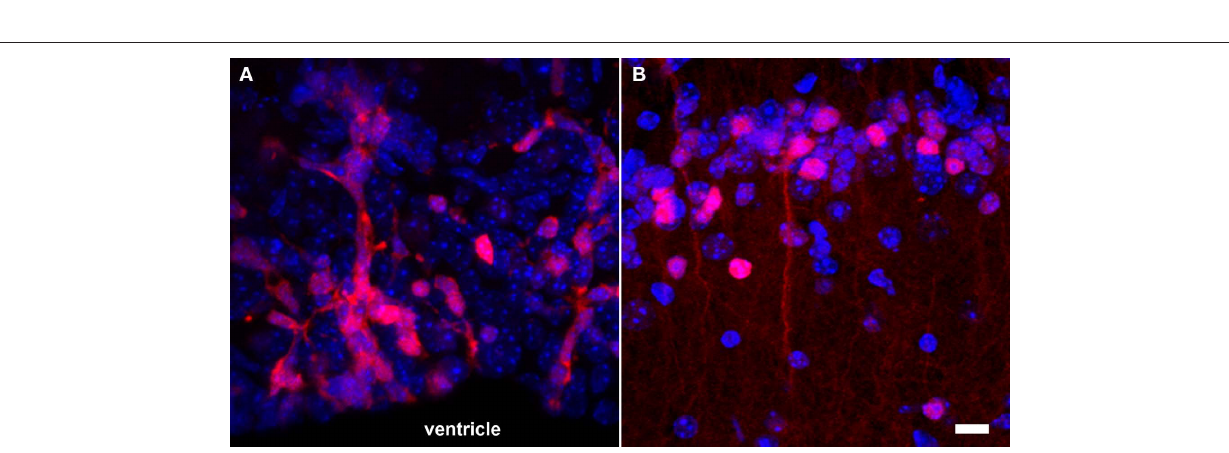
FIguRE 4 | Fluorescence-based imaging of neurogenesis using transgenic expression of DsRed under the control of the doublecortin promoter. (A) A large number of neuronal precursors (red) are generated in the SVZ and migrate in toward the olfactory bulb along the RMS; (B) once neuroblasts (red) reach the granular cell layer of the olfactory bulb, they start to functionally integrate and have a more complex cellular morphology. Nuclei appear in blue. Scale bar = 10